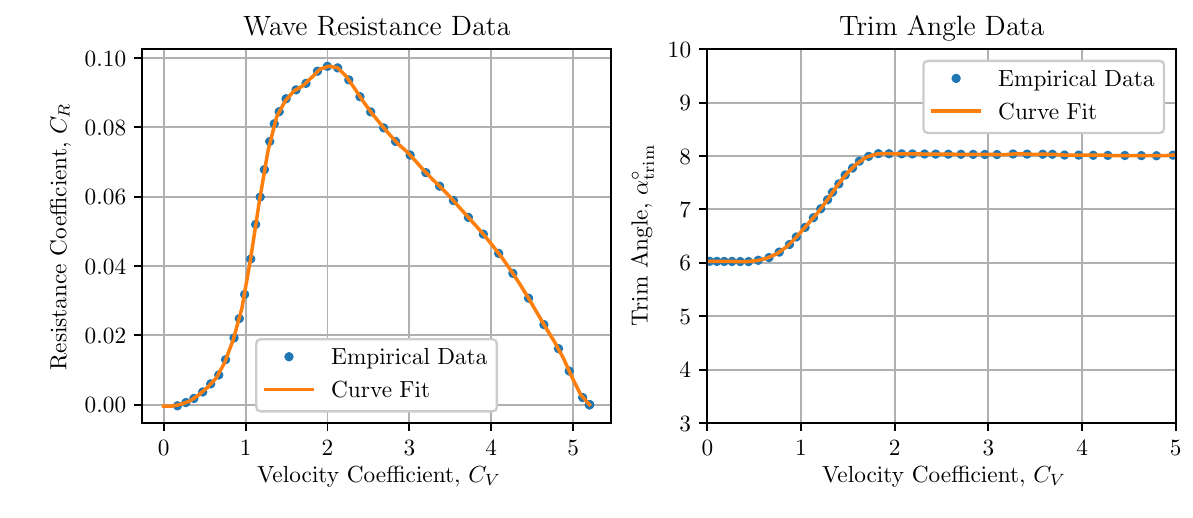
Figure 6. NACA TN-2481 planing hull data.